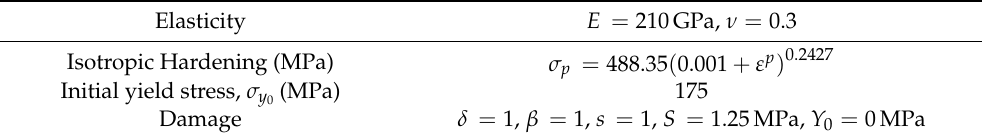
Table 4. Material properties considered in bulge test.